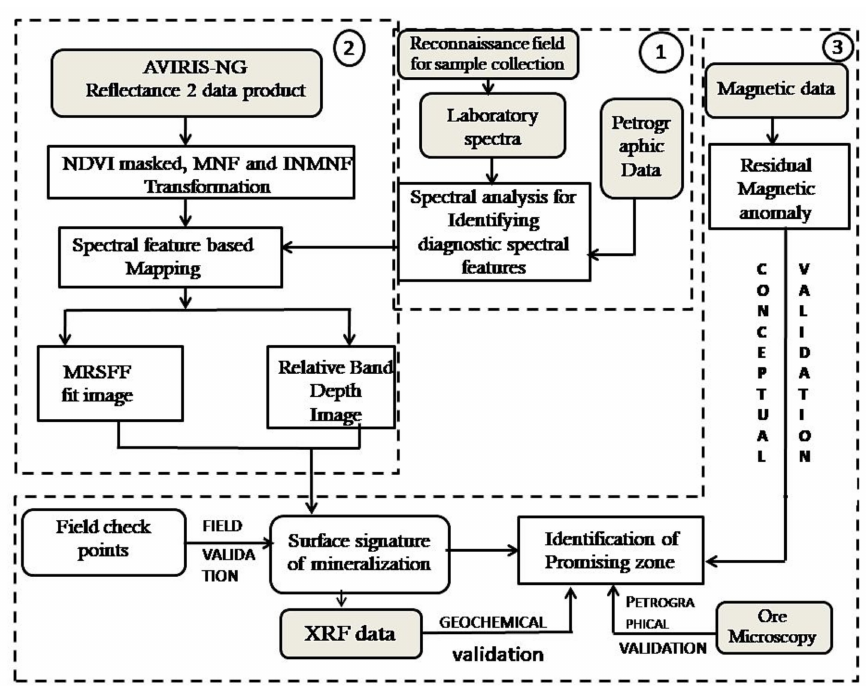
Figure 2. Flow chart showing the major steps followed in the study. In the flow chart, three major segments of the work are shown with dotted outline and numbers. The major segments in the methodology are 1 : collection and rock spectra, and mineralogical analysis of spectral feature; 2 . AVIRIS-NG data processing and spectral mapping; 3 . validation using XRF, Ore microscopy, ground magnetic, and field